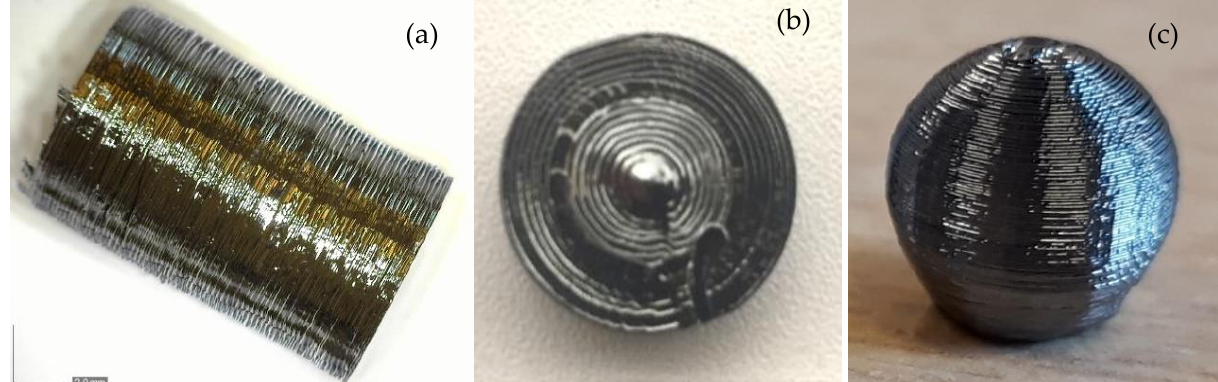
Figure 3. Chalcogenide 3D printed samples: ( a ) chalcogenide cylinder, ( b ) chalcogenide disk ( c ) chalcogenide bead.